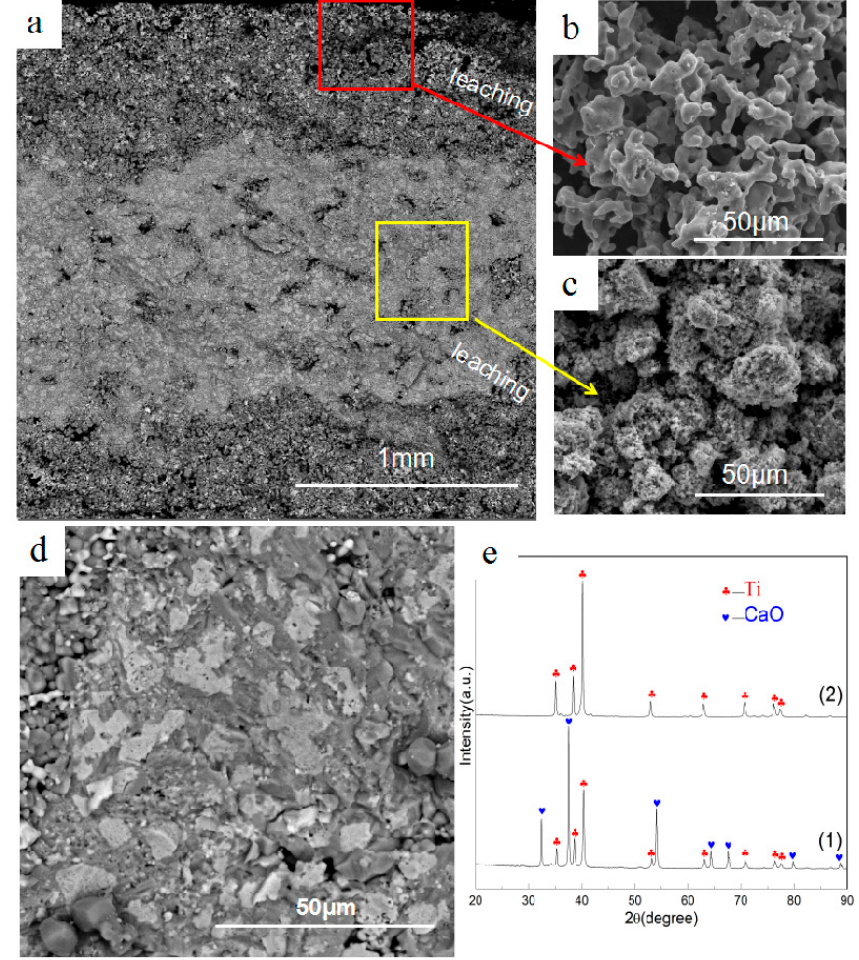
Figure 4. The SEM images and XRD pattern of cross section of reduced products: ( a ) the cross section of reduced products; ( b , c ) the samples after leaching; ( d ) The middle area of cross section; ( e1 ) the XRD pattern of ( d ); ( e2 ) the XRD pattern of the leaching sample.